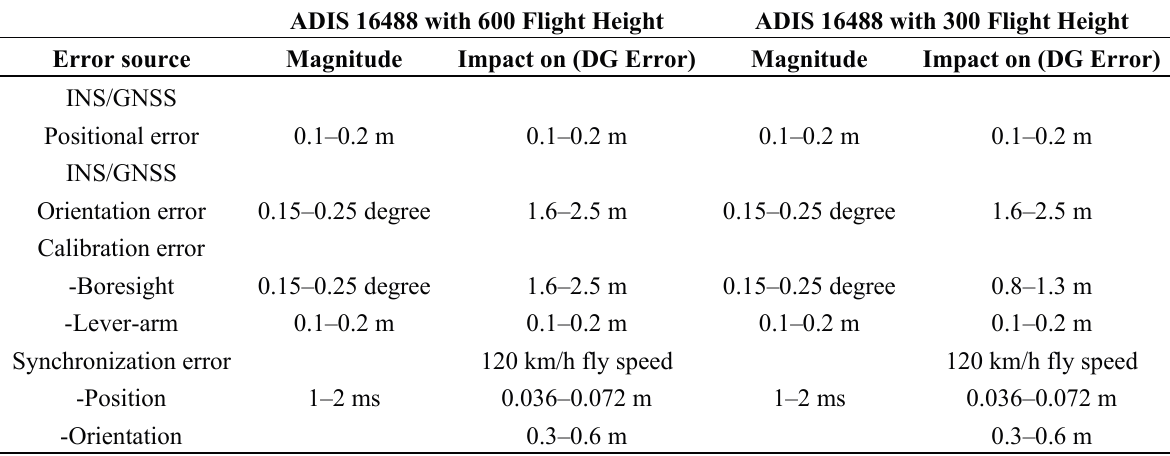
Table 6. Error budgets of the new DG